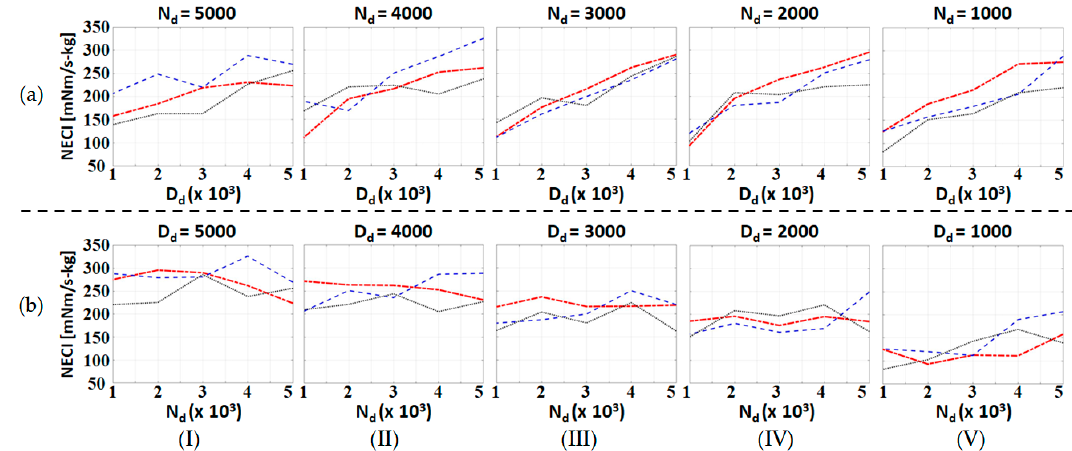
Figure 9. Plot of NECI for a series of experiments with different admittance parameters: ( a ) N d is fixed and D d varies; and ( b ) D d is fixed and N d varies. The red dot-dashed line, blue dashed line and the black dotted line represent the data of Subject 1, Subject 2 and Subject 3, respectively.